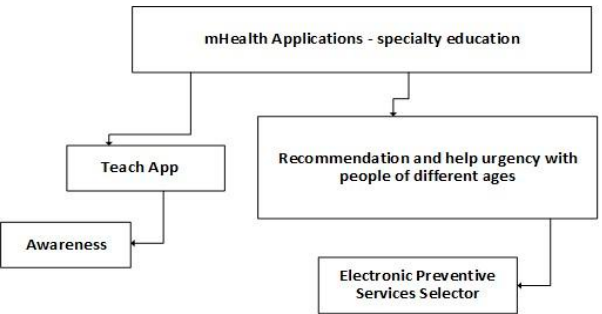
Figure 5. Classification of mobile health applications related to specialty education.